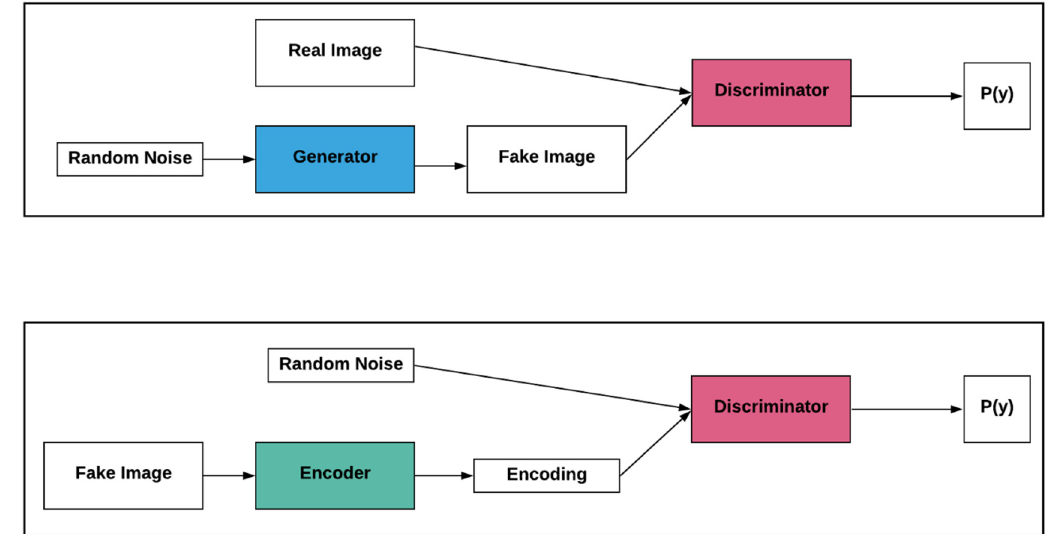
Figure 10. An illustration of the algorithm used in [71]. The top section follows a typical GAN architecture. In the bottom section, this process is reversed. A fake image generated by the generator is passed to an encoder which creates an encoding. The discriminator is then tasked with identifying which vector, either random noise or encoding, comes from the original distribution.